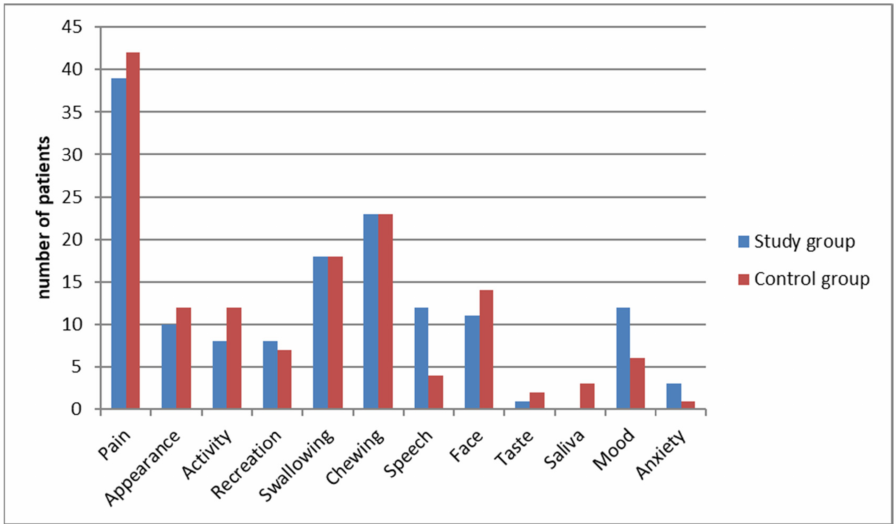
Figure 2. Important issues for patients during recovery after removal of